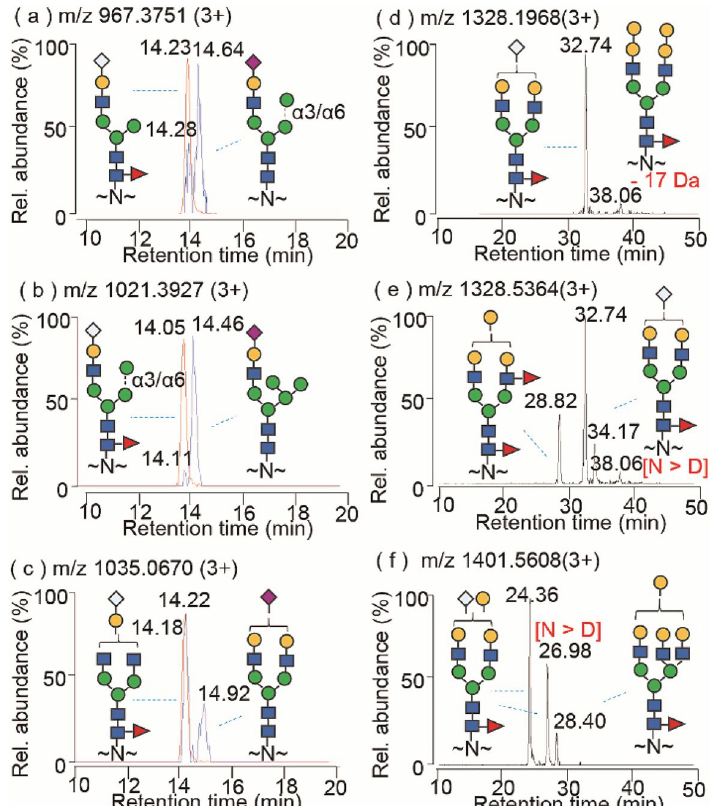
myeloma cells (red lines); ( d – f ) Cetuximab α-Gal containing Fab N -glycopeptides. Modifications include the identified deamidation of Asn to Asp (N > D) and the neutral loss of a 17 Da molecule of the